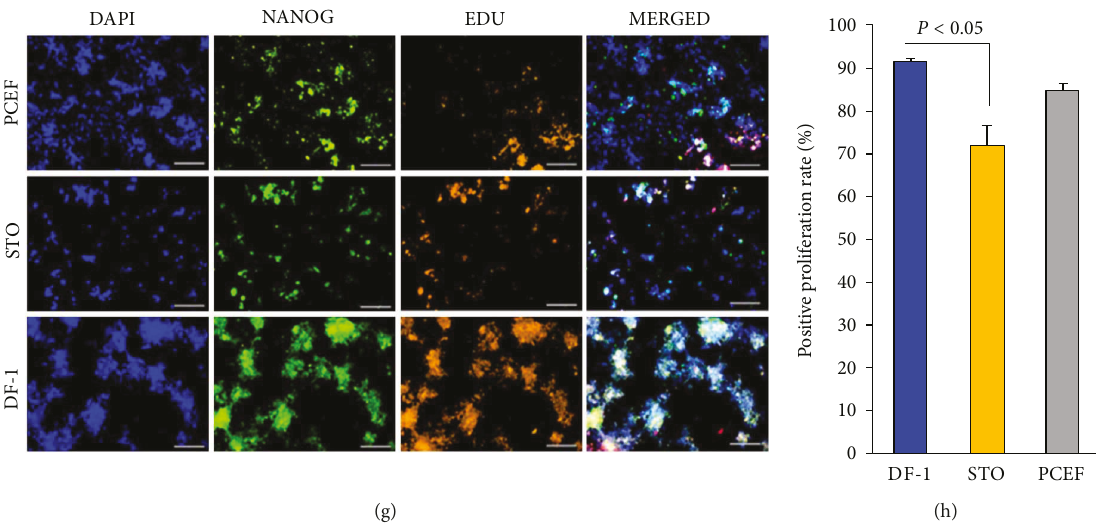
(g) Figure 1: The e ff ect of feeders and factors on the development of avian blastodermal cells. (a) bFGF is vital to the culture of avian blastodermal cells in vitro . cESCs were plated in the presence of or in the absence of growth factors as indicated in the fi gure. Crystal violet staining was performed after 4 passages. (b) The areas of colonies with crystal violet staining were counted by Image-Pro Plus. ∗ Compared to the control group, there is a signi fi cant di ff erence ( P < 0 05 ). # Compared to the LIF, SCF, and LIF+SCF groups, there is a signi fi cant di ff erence ( P < 0 05 ). (c) The combination of 20ng/ μ l each of hLIF, hbFGF, and mSCF was the optimal concentration. cESCs were plated in 0, 10, and 20 ng/ μ l each of hLIF, hbFGF, and mSCF, respectively. Four passages later, crystal violet staining was performed. (d) The areas of colonies were calculated by Image-Pro Plus. The colony area in the presence of 20ng/ μ l growth factors was the biggest ( P < 0 01 ). (e) The inactivated DF-1 feeder was the optimal feeder for supporting cESCs in vitro compared to STO and pCEF feeders. (f) The areas of colonies with crystal violet staining after 4 passages were counted by Image-Pro Plus. The colony area on the DF-1 feeder was the biggest ( P < 0 01 ). (g) The cultured cESCs after 4 passages on di ff erent feeders were performed by DAPI (blue), EDU (green), and NANOG (orange) staining. Scale bar: 150 μ m. (h) The bars indicated the positive proliferation rate of the cultured cESCs after 4 passages on di ff erent feeders. Cells on the DF-1 feeder and pCEF feeder showed the highest proliferation rate ( P < 0 05 ). All results are expressed as the mean ± SD of three independent experiments. Scale bar: 100 μ